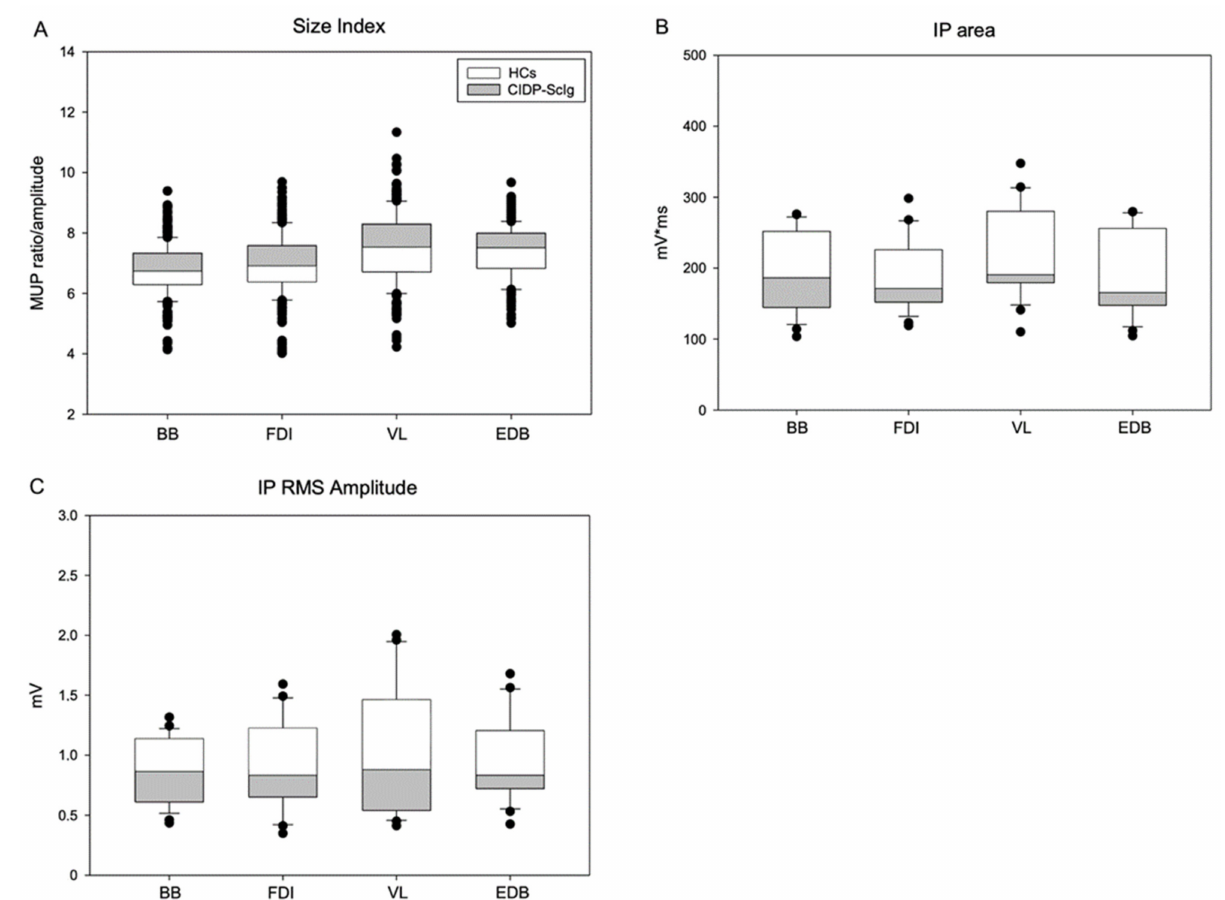
Figure 3. ( A ) Size index and ( B , C ) interference pattern analysis (IPA) in CIDP patients after ScIg treatment and HCs. Figure legend: HCs: healthy controls; CIDP: chronic inflammatory demyeli- nating poly-neuropathy; ScIg: subcutaneous immunoglobulin; BB: brachial biceps; FDI: first dorsal interosseous; VL: vastus lateralis; EDB: extensor digitorum brevis; MUP: motor unit potential; IP: interference pattern; RMS: root mean